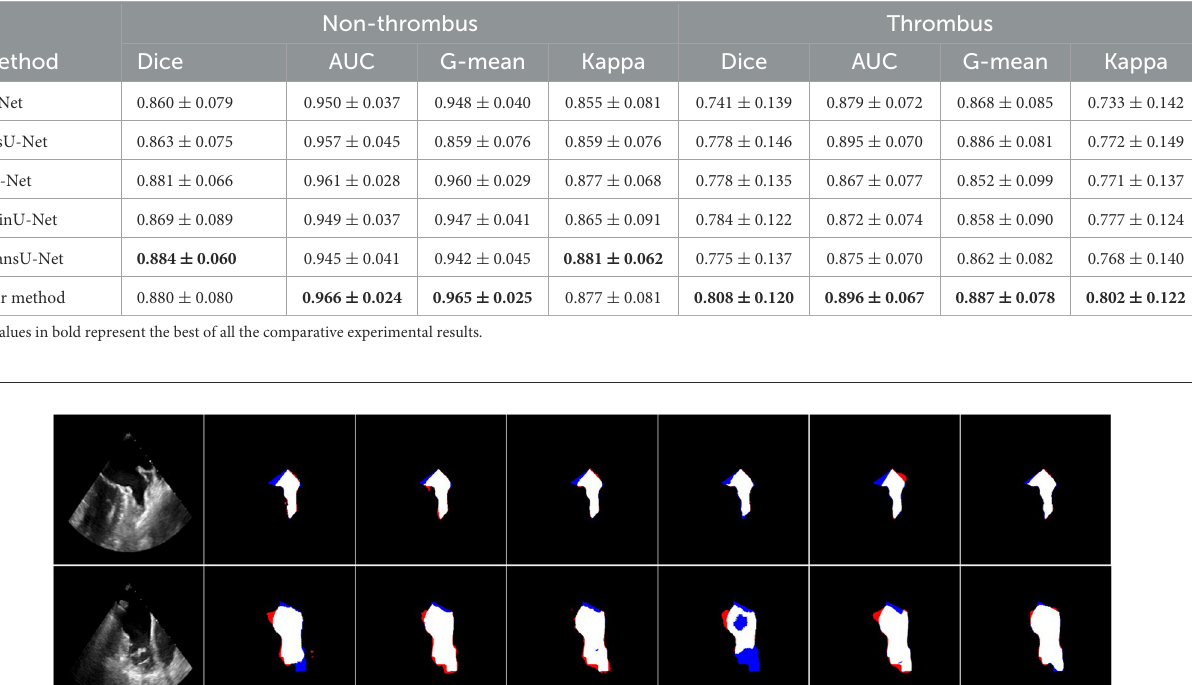
TABLE 2 LAA segmentation performance of the comparative methods for the non-thrombus and thrombus groups.